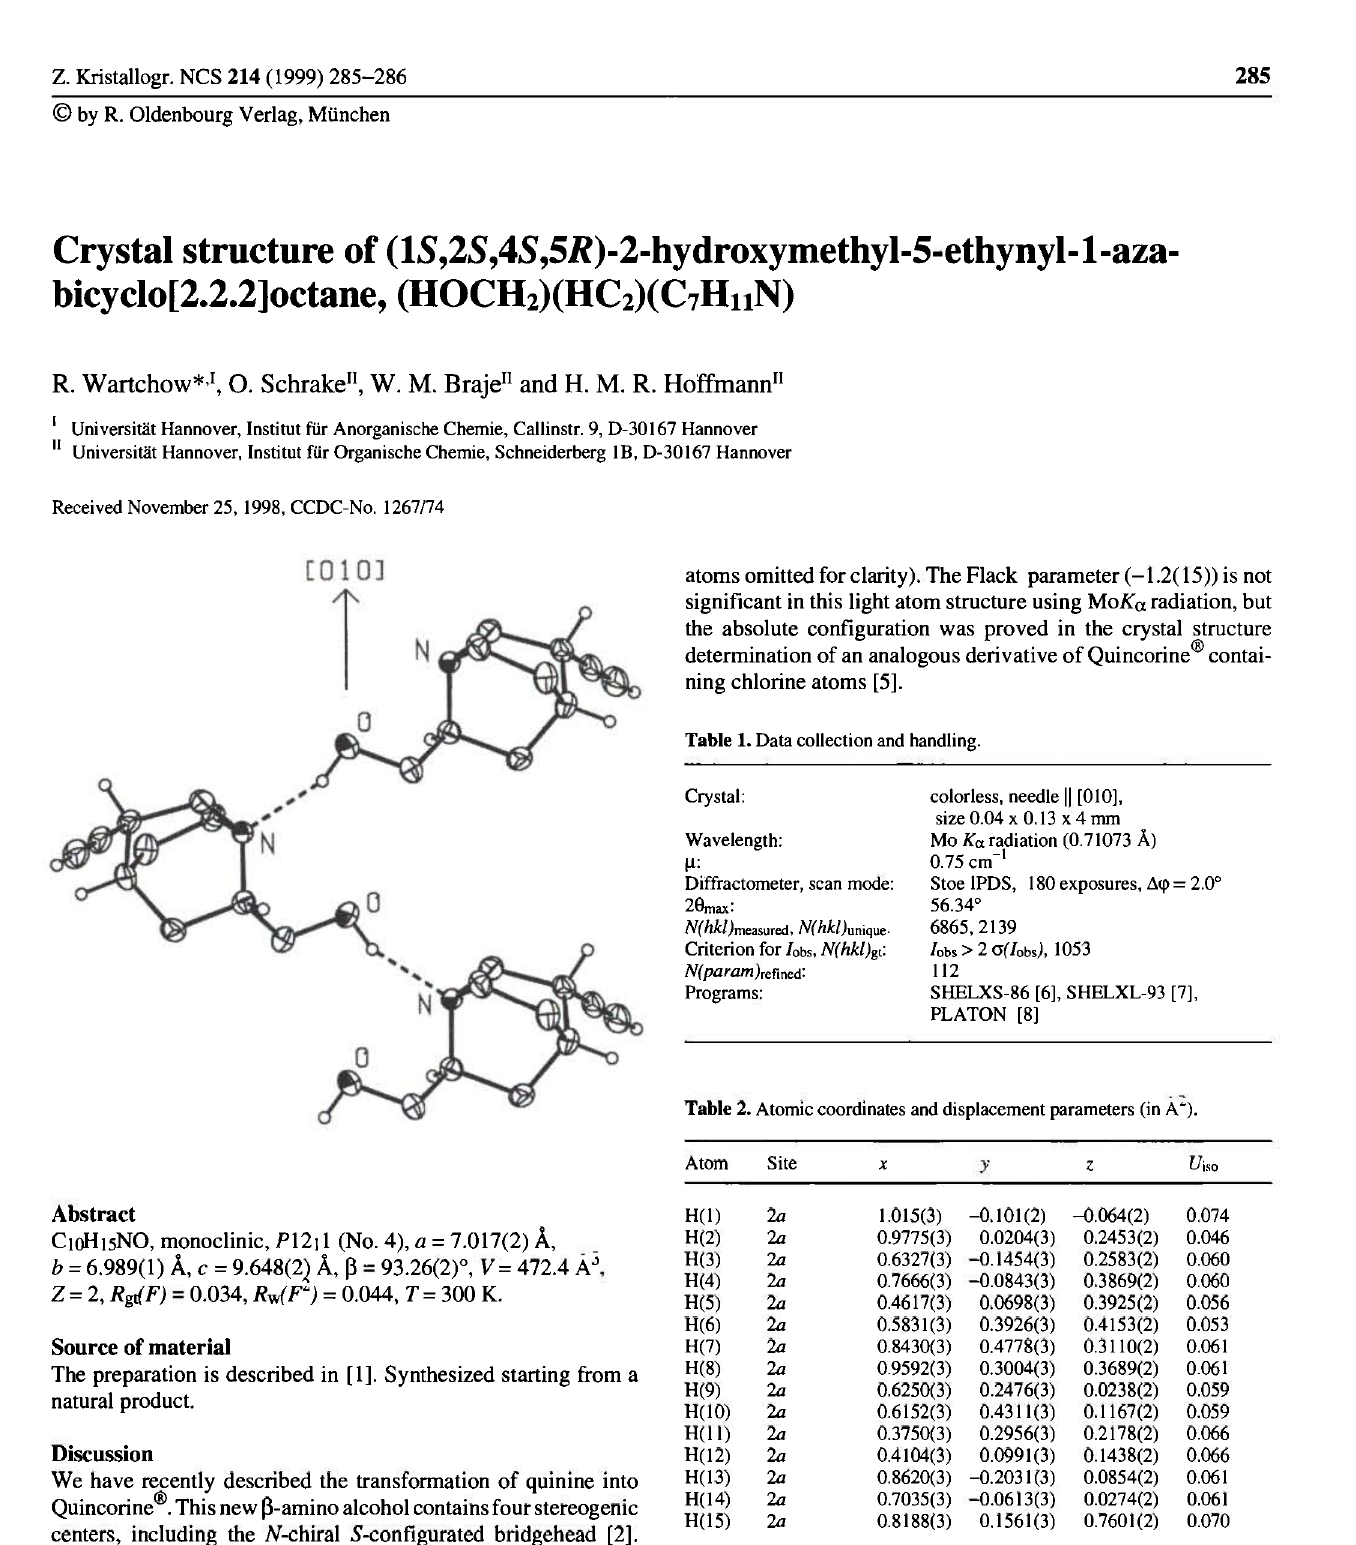
Table 2. Atomic coordinates and displacement parameters (in A